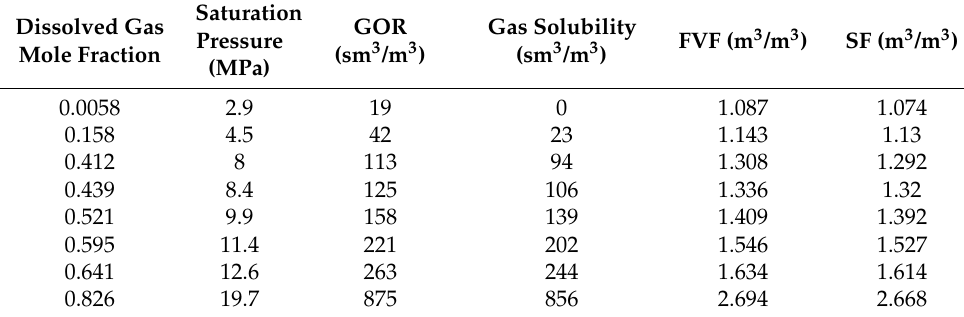
Table 2. PVT properties of the reservoir fluid and CO 2 mixtures at 140 ◦ F. Dissolved Gas Mole Fraction